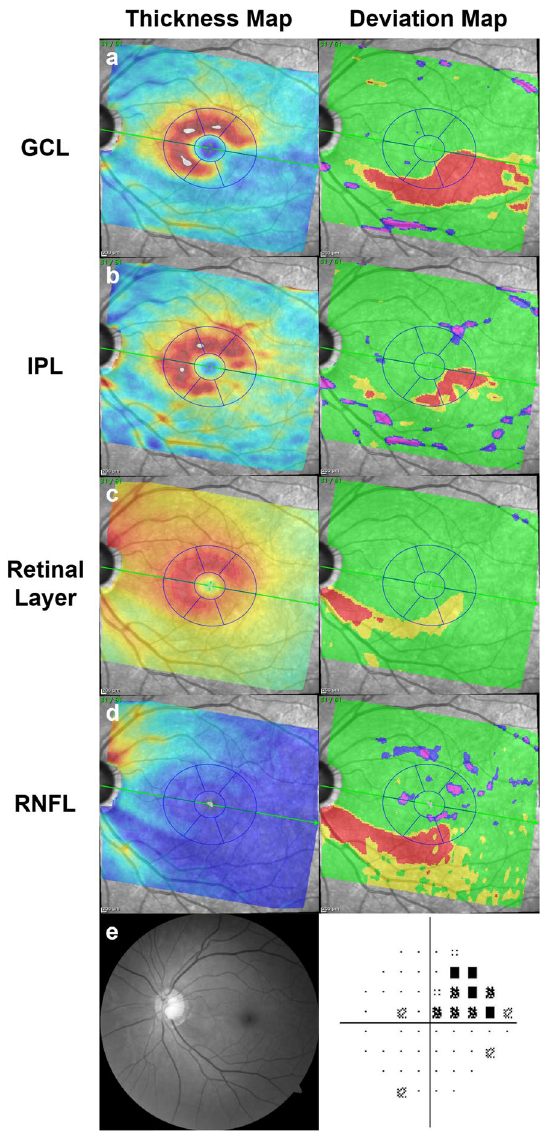
Figure 4. Spectralis OCT deviation maps of segmented macular layers and retinal nerve fiber layer (RNFL) in glaucomatous eye. Each labeled row ( a – d ), from left to right, consists of a thickness map and a deviation map, except for e with red-free RNFL photography and Humphrey (Carl Zeiss Meditec) C24–2 visual field. A patient with open-angle glaucoma showing inferior localized glaucomatous defects on the ganglion cell layer